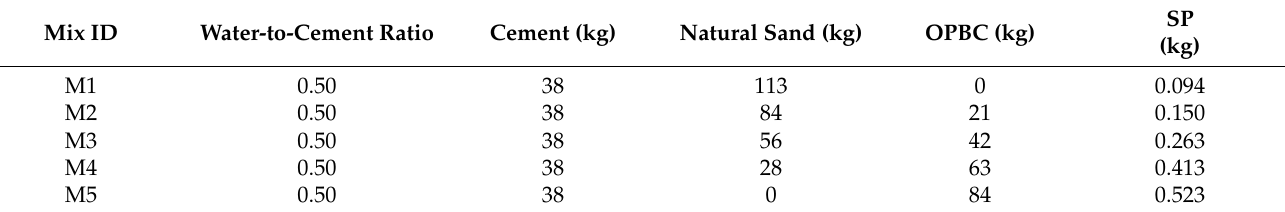
Table 4. Mix proportions of mortar mixtures in one batch.